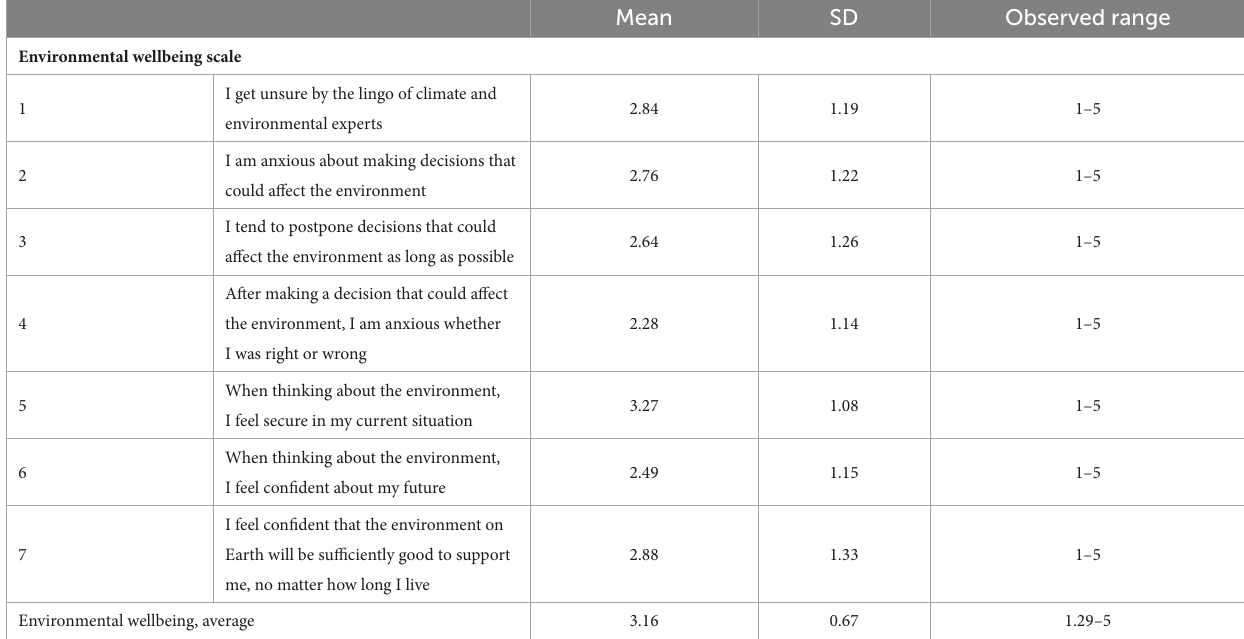
TABLE 1 Summary statistics of the environmental wellbeing